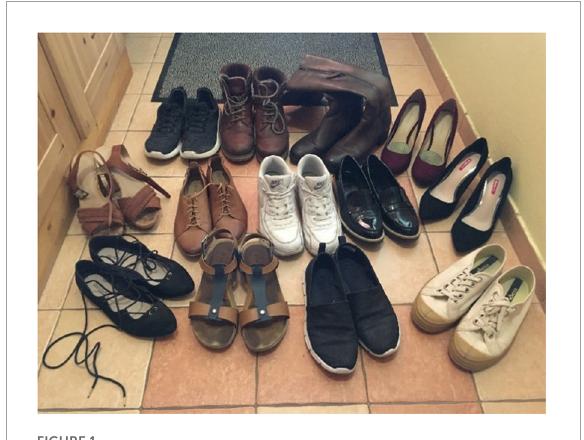
FIGURE1 Photograph of a shoe collection, Participant